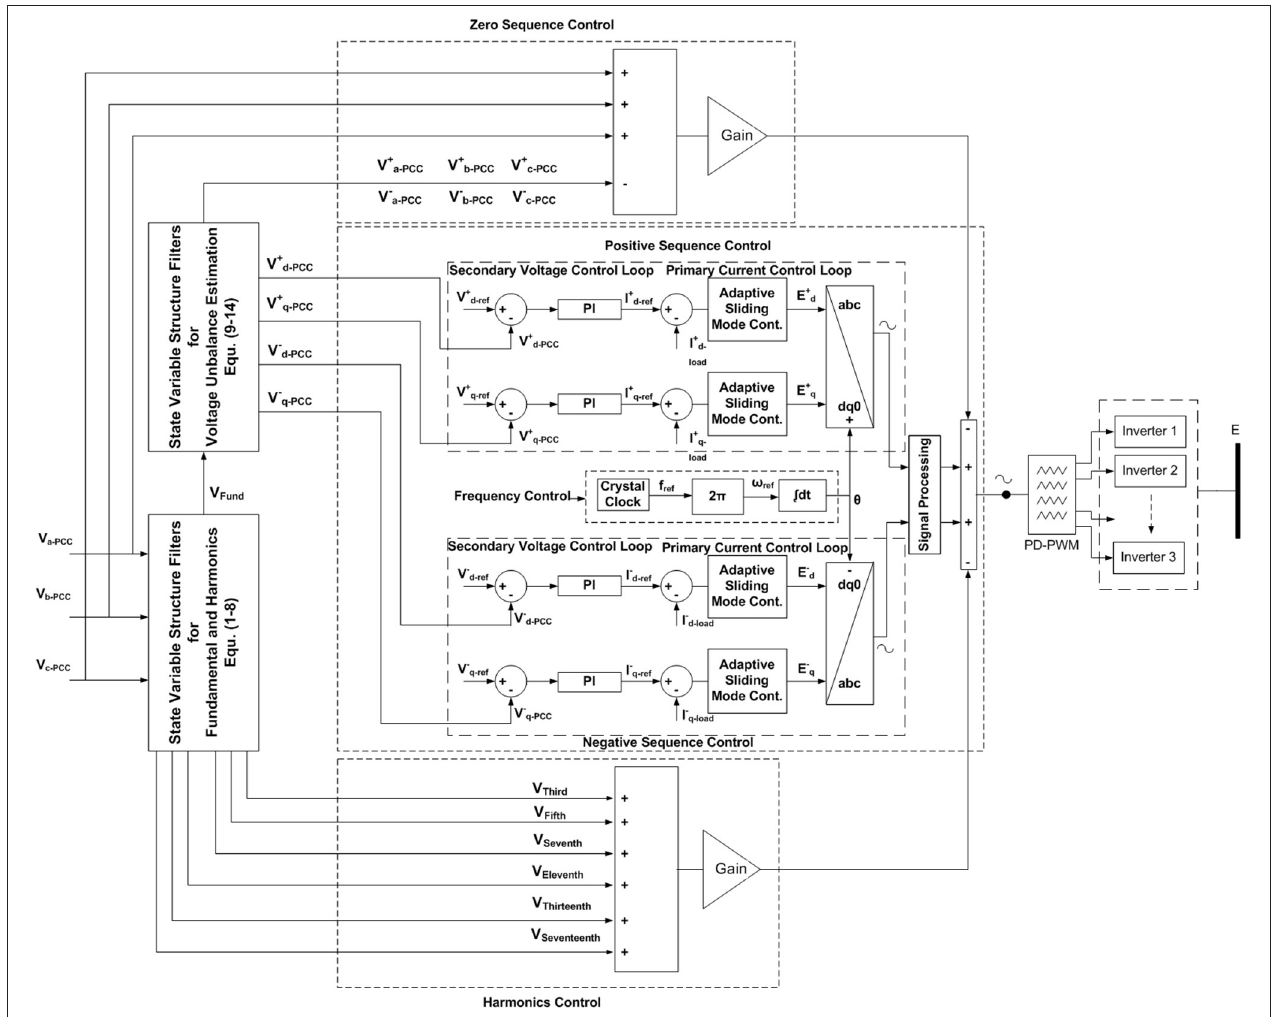
FIGURE 3 | Suggested operational (control) scheme for